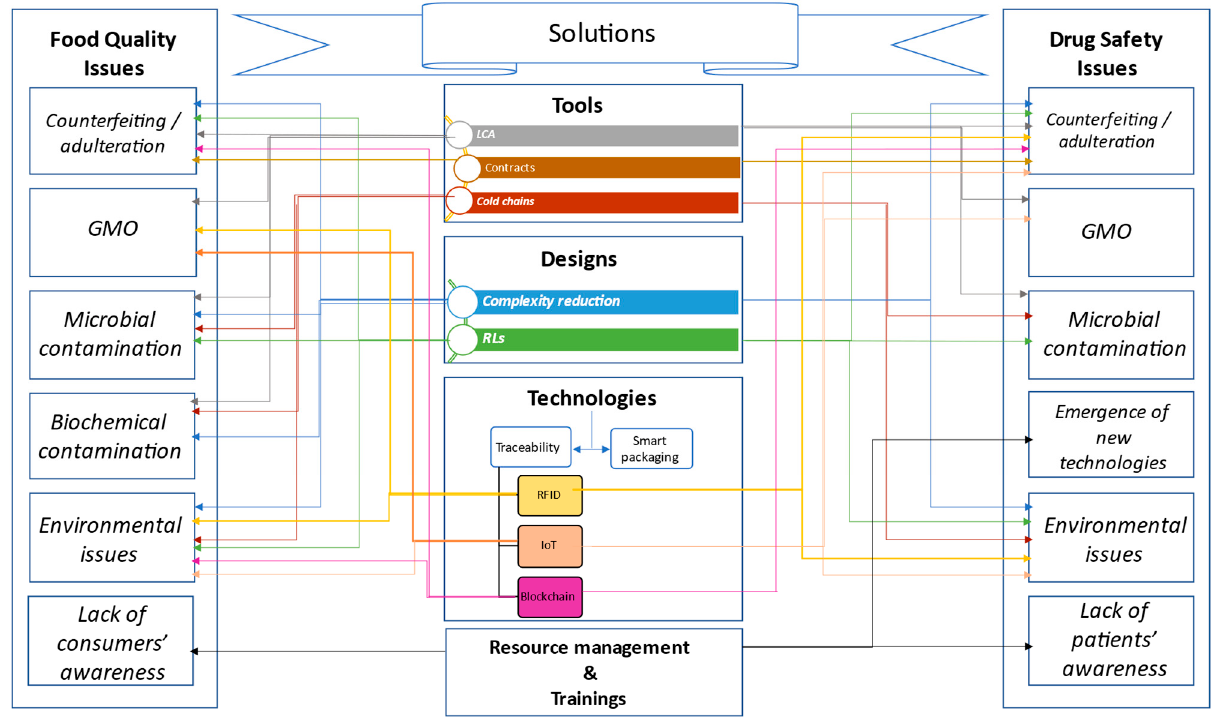
Figure 4. Integrated framework for solving issues of food quality & drug safety.